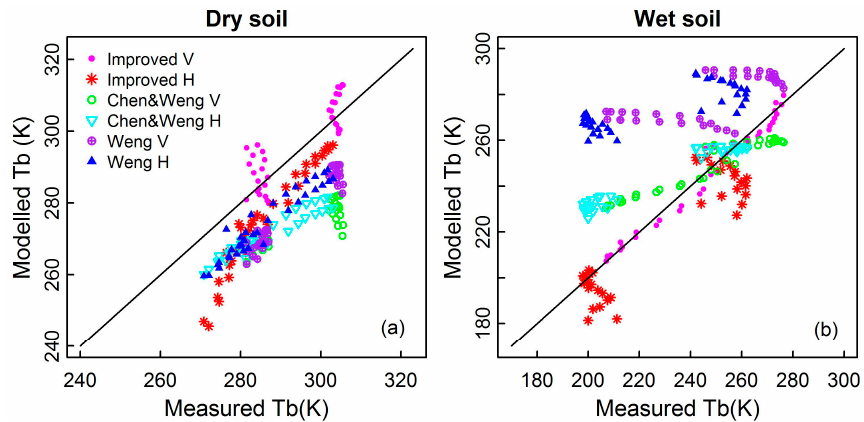
Figure 6. Simulated brightness temperatures ( Tb : brightness temperature in K ) compared with the ground-based measurements for ( a ) dry soil and ( b ) wet soil using the Weng, Chen and Weng, and parameterized soil-surface emissivity models for vertical ( V ) polarization and horizontal ( H ) polarization. The input parameters of soil conditions are listed in Table 3.